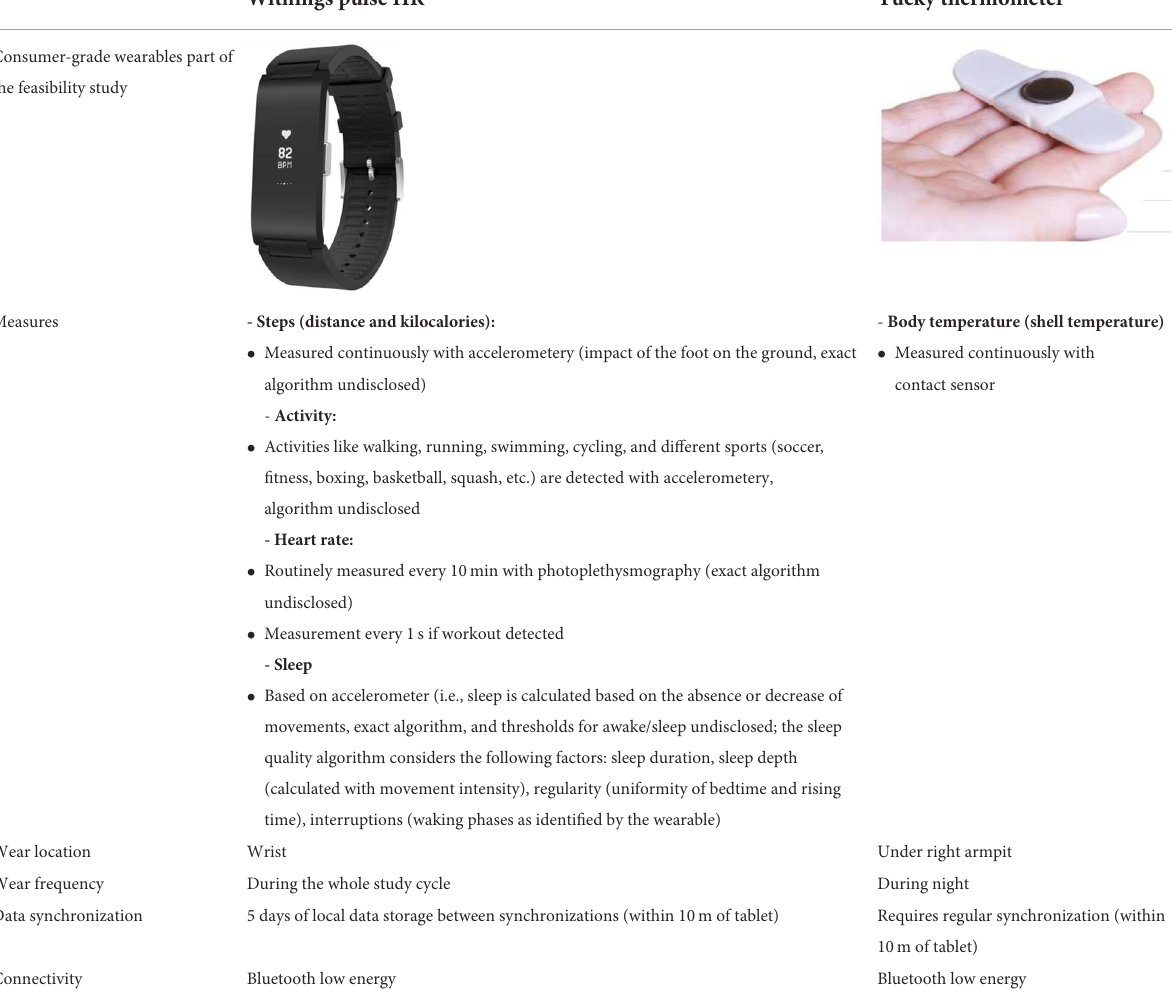
TABLE 1 Details on Withings Pulse HR fitness tracker (WPHR) and the Tucky thermometer patch [adopted from the protocol (4)]. Withings pulse HR Tucky